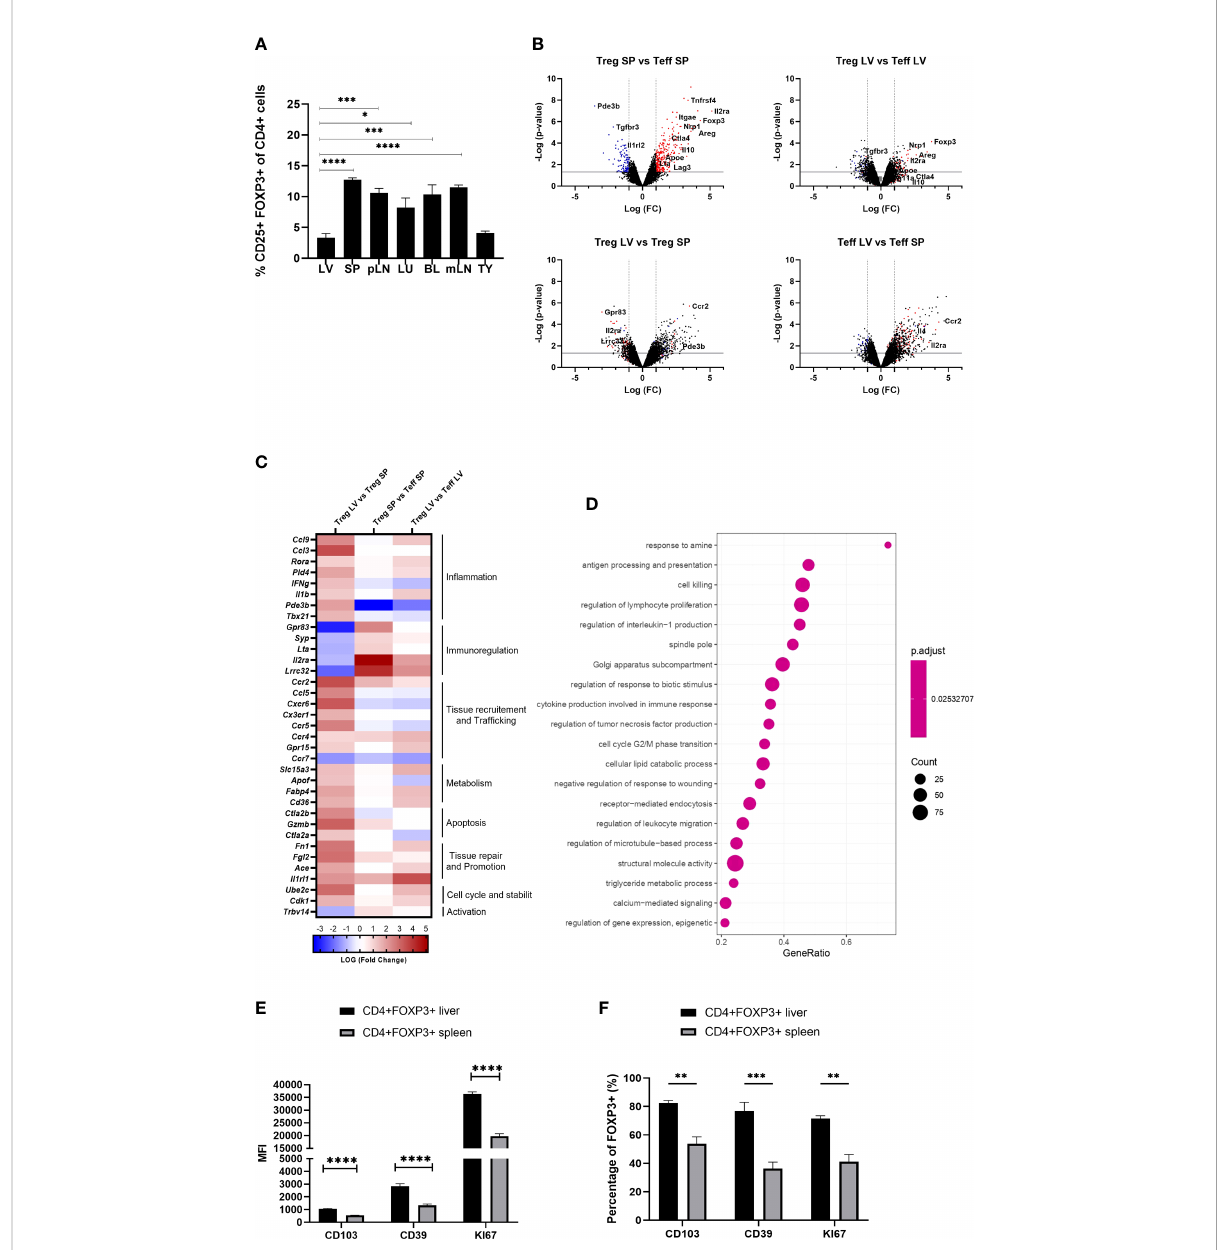
FIGURE 1 Intra-hepatic Tregs are less abundant but remain to exhibit a core Treg transcriptional signature and have a distinct molecular pro fi le. (A) Quanti fi cation of the proportion of Foxp3+ CD4+CD25+ cells in the homogenised tissues of liver (LV) (n>8), spleen (SP) (n>8), peripheral lymph nodes (pLN), lung (LU), adipose tissue (AT), blood (BL), mesenteric lymph nodes (mLN) and thymus (TY) in homeostasis (n=4). (B – D) Whole genome microarray analysis in intra-hepatic and splenic Tregs versus T-effectors in Foxp3-YFP B6 mice (n=3). (B) Volcano plots showing difference in the transcriptome pro fi le of intra-hepatic and splenic Tregs using normalised p-value versus fold change of all 20515 genes and splenic “ Treg signature ” is de fi ned by up-regulated (red) and down-regulated (blue) genes above p-value of 0.05 and Fold change 2. (C) Heatmap exhibits pre-selected differentially expressed genes relevant to Treg function, tissue residency, tissue repair and metabolism between intra-hepatic and splenic Treg population and the signi fi cance is determined above p-value of 0.05 and Fold-change 2 (D) Gene set enrichment analysis of intra-hepatic Tregs compared with the splenic Tregs. Dot plot shows the top 20 up-regulated GO pathways of biological processes, molecular functions and cellular components with an FDR adjusted q-value of 0.020506. Dot size represents the number of genes enriched in the pathway, and gene ratio represents the ratio of the count of core enrichment genes to count of pathway genes. (E) CD4+Foxp3 + cells were gated from homogenised liver and spleen tissue to quantify the MFI of CD103, CD39 and KI67 (n=5). (F) Percentage of Foxp3+ cells expressing CD103, CD39 and KI67. Signi fi cance was determined by ordinary one-way ANOVA with Sidak ’ s multiple comparison test for (A) and two-way ANOVA with Tukey multiple comparison test for (E, F) and the values are shown as the mean ± SEM. For B-D, p<0.05 and Fold